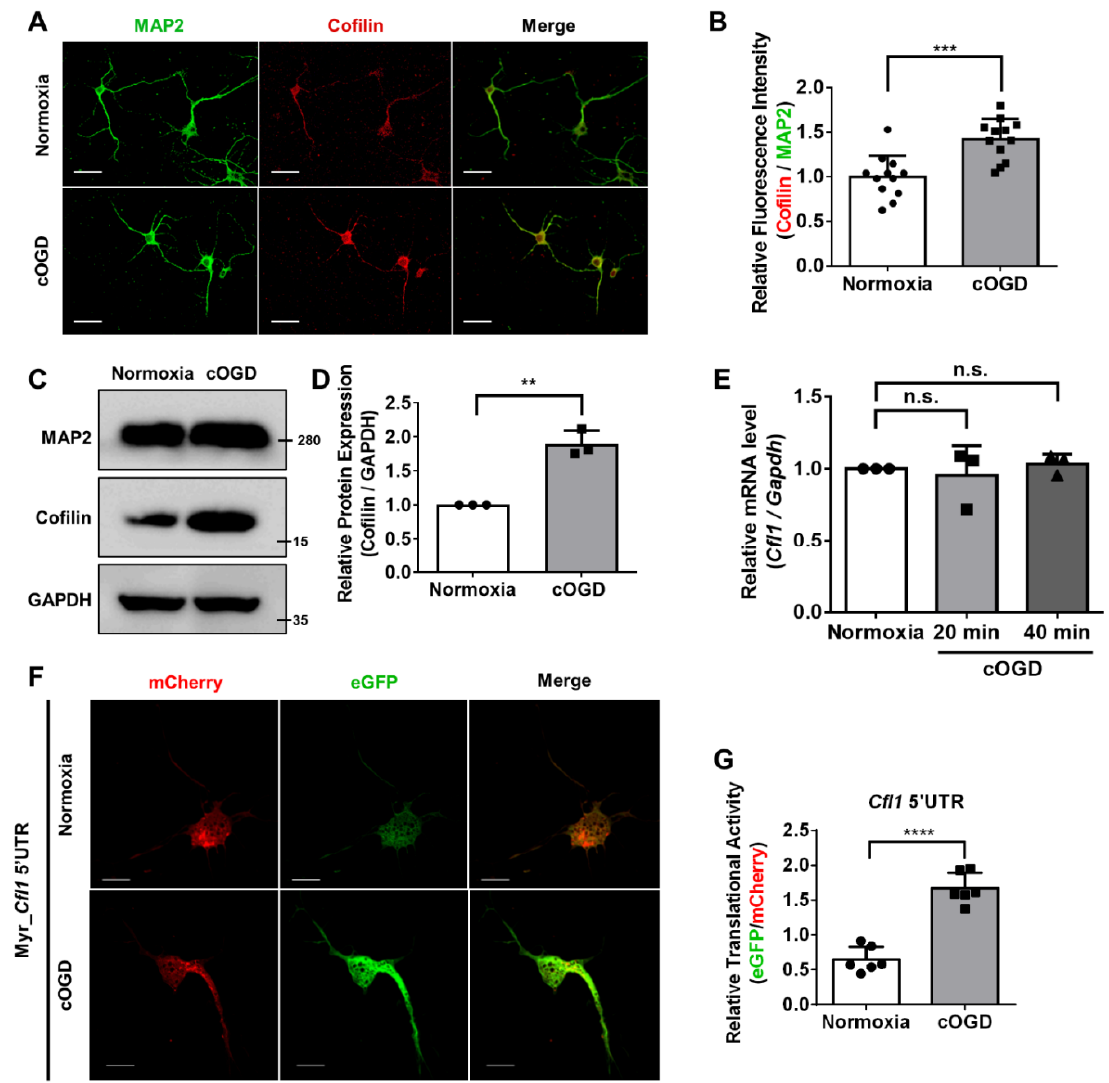
Figure 1. The translational activity of Cfl1 mRNA is enhanced in cOGD neuron. ( A ) The immunofluorescence labeling of cofilin (red) and MAP2 (green) in the primary hippocampal neuron that was cultured under normoxia conditions (top) or chemically oxygen–glucose-deprived (cOGD) conditions (bottom). Scale bar = 30 µ M. ( B ) Quantification of relative fluorescence intensity of cofilin from ( A ) normalized to MAP2 ( n = 12). ( C ) Representative immunoblot of cofilin in normal neuron (left) and cOGD neuron (right). GAPDH was used as loading control. ( D ) Quantification of protein level of cofilin from ( C ). ImageJ was used to measure the intensity of the blot ( n = 3). ( E ) Quantitative reverse transcription polymerase chain reaction (RT-qPCR) analysis of Cfl1 mRNA level in primary hippocampal neuron cultured under normoxia conditions (white) and cOGD conditions (grays) ( n = 3). ( F ) Measuring the translational activity of Cfl1 mRNA using mCherry (red)— eGFP (green) bicistronic vector with Cfl1 5 (cid:48) UTR, in the primary hippocampal neuron that was cultured under normoxia conditions (top) and cOGD conditions (bottom). Scale bar = 10 µ M. ( G ) Quantification of relative translational activity of Cfl1 mRNA by measuring the eGFP to mCherry ratio in the normal neuron (white) and cOGD neuron (gray) ( n = 6). n.s., not significant, ** p ≤ 0.01, *** p ≤ 0.001, **** p ≤ 0.0001; unpaired Student’s t test was performed for ( B , D , G ); ordinary one-way ANOVA with Tukey’s multiple comparison test was performed for ( E ). “ n ” represents the number of independent experiments. Error bars indicate